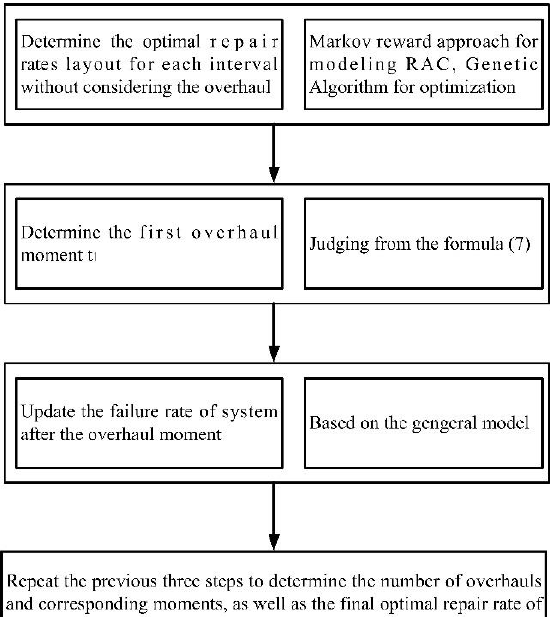
Figure 3. Machine tools maintenance planning